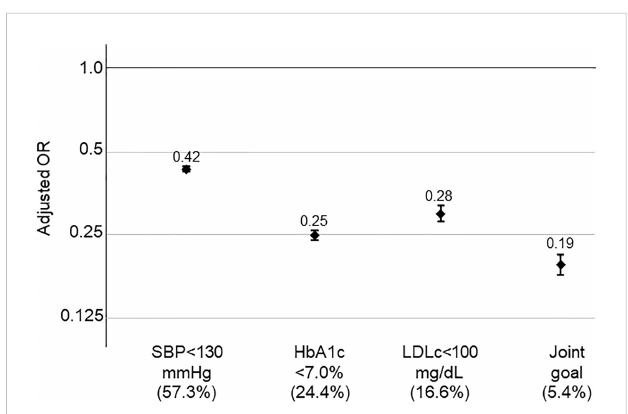
FIGURE 1 Association between sustained metabolic control and mortality. Data are odds ratios compared to participants not reaching sustained achievement of each goal, adjusted for sex, age, race (black vs other), insurance type and baseline BMI. Error bars represent 95% con fi dence intervals. Numbers in parentheses represent the percentage of study participants who sustained control of each goal over study